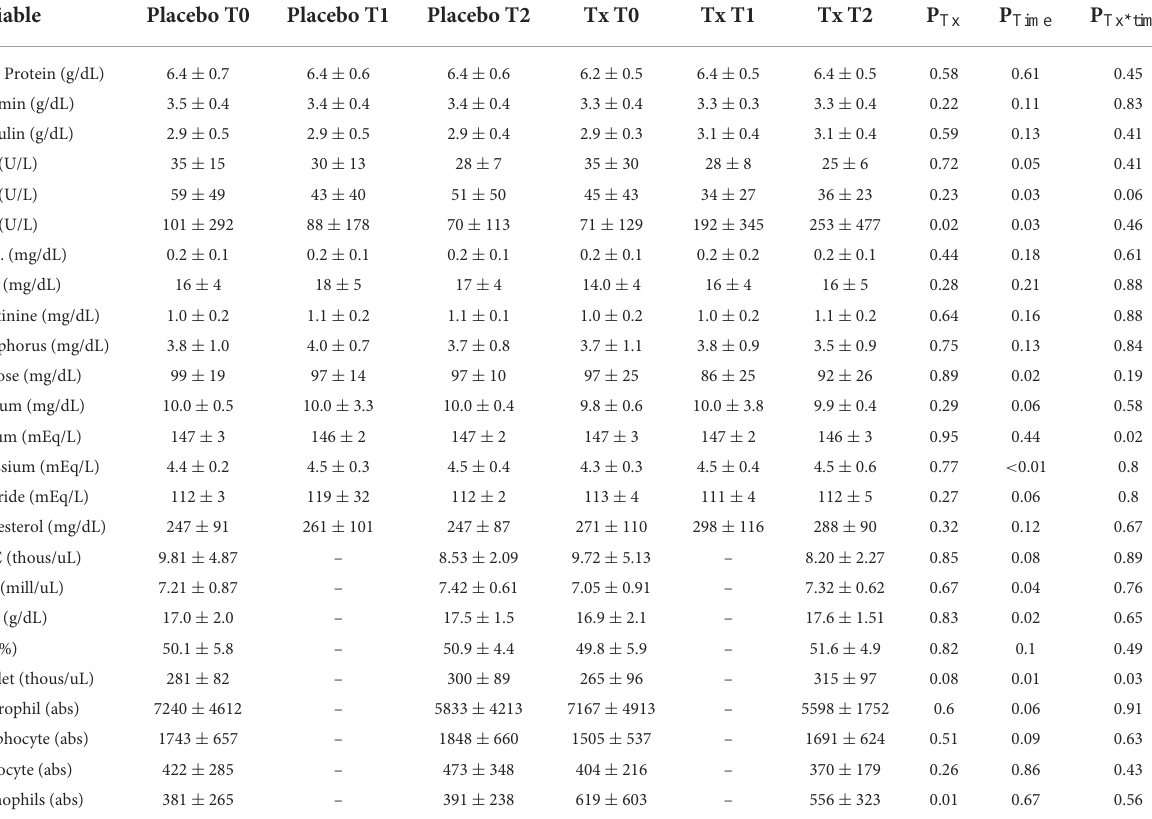
TABLE 4 Clinicopathologic values of complete blood count and serum biochemistry in dogs treated with either a cannabidiol (CBD) and cannabidiolic (CBDA) rich hemp product (2–2.5 mg/kg orally every 12h; n = 22) or a placebo (sesame seed oil every 12h, n = 19) for 4 weeks after a tibial plateau leveling osteotomy